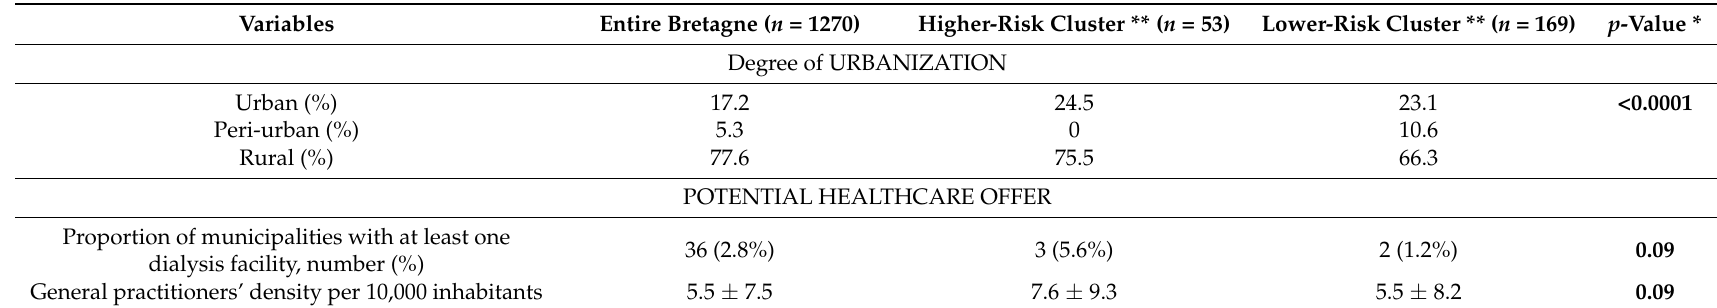
Table 4. Description of the degree of urbanization and potential healthcare offer characteristics of the municipalities in the entire Bretagne region and within the higher-risk and lower-risk clusters (no. of municipalities =